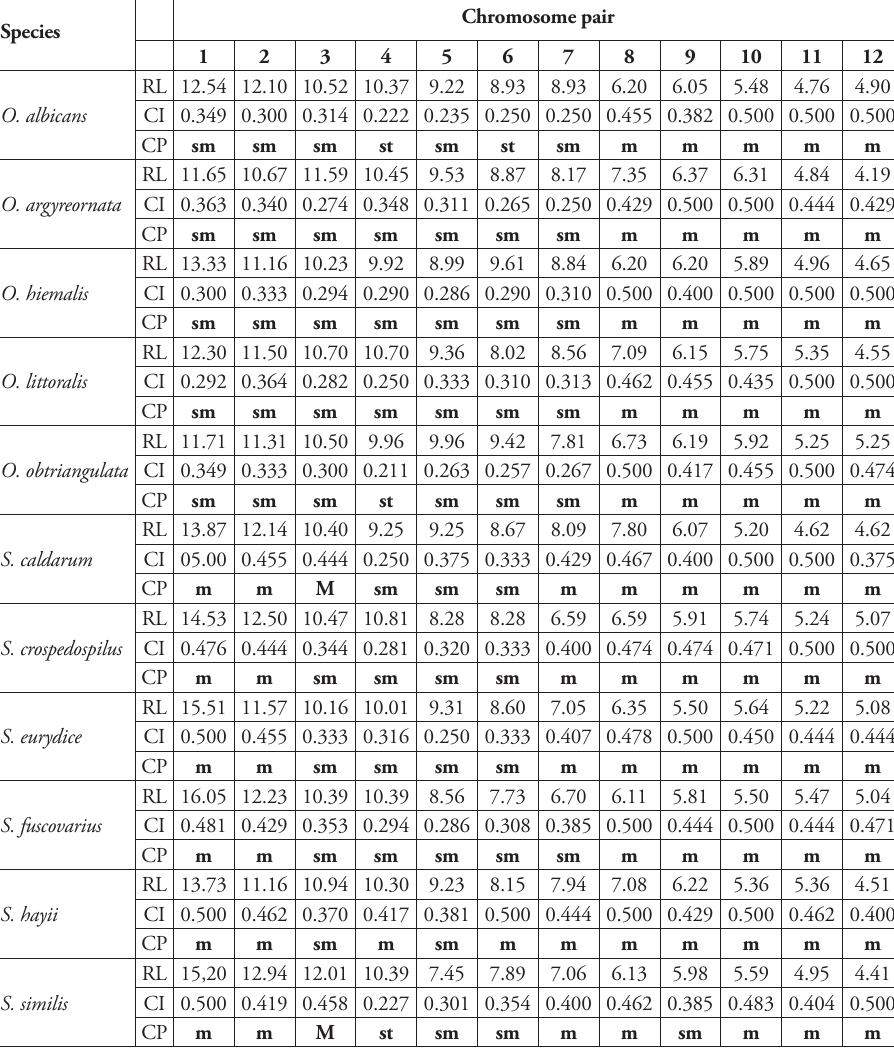
m = metacentric; sm = submetacentric; st =